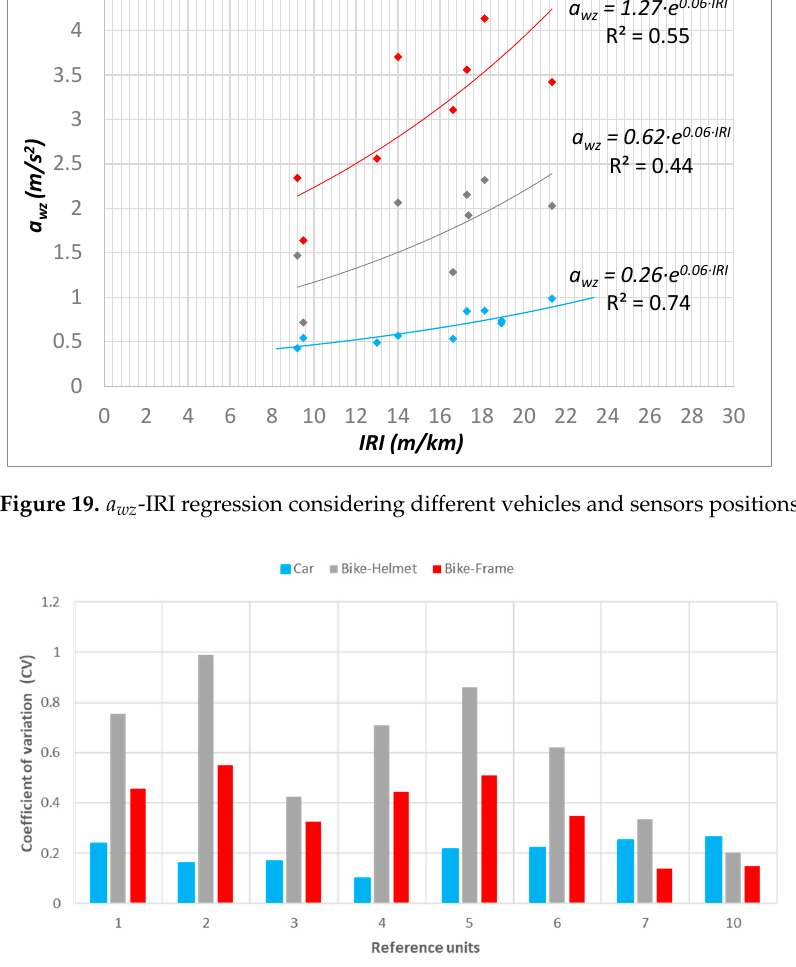
Figure 20. Coefficients of variations related to the a wz values calculated in the sample units surveyed in bicycle and car during the field tests.